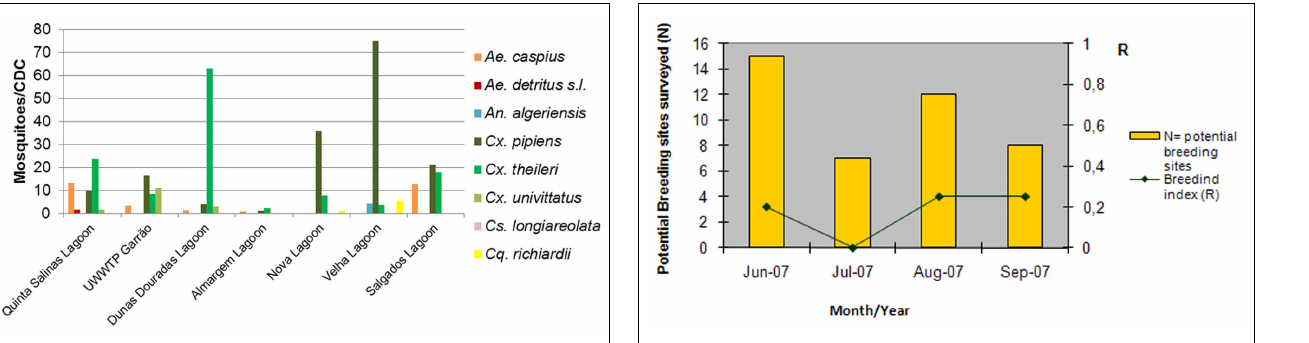
FIGURE 5 | Potential breeding sites surveyed for immature culicids along the seven lagoons surveyed, and respective breeding index, from June to September 2007.